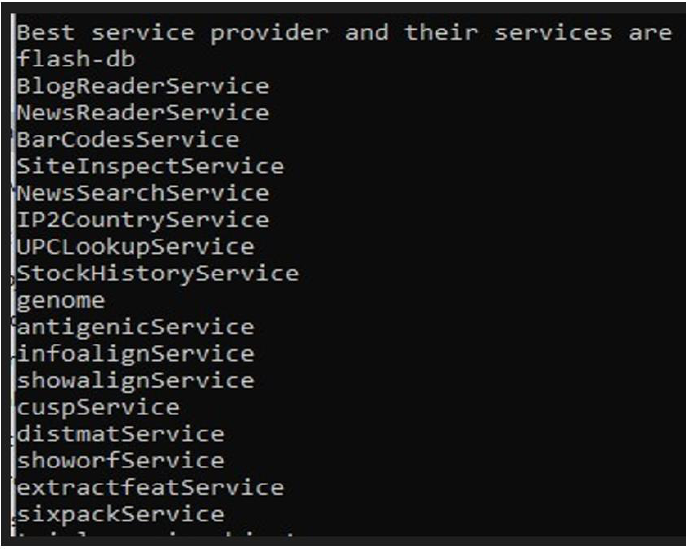
Figure 4. Finest service providers and their best offerings.